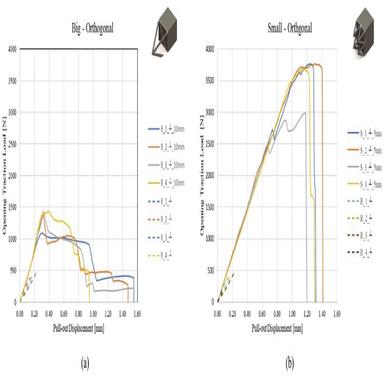
Load-displacement curves for both the orthogonal configurations. 11a) Big pyramids and reference samples; 11b) small pyramids and reference samples.